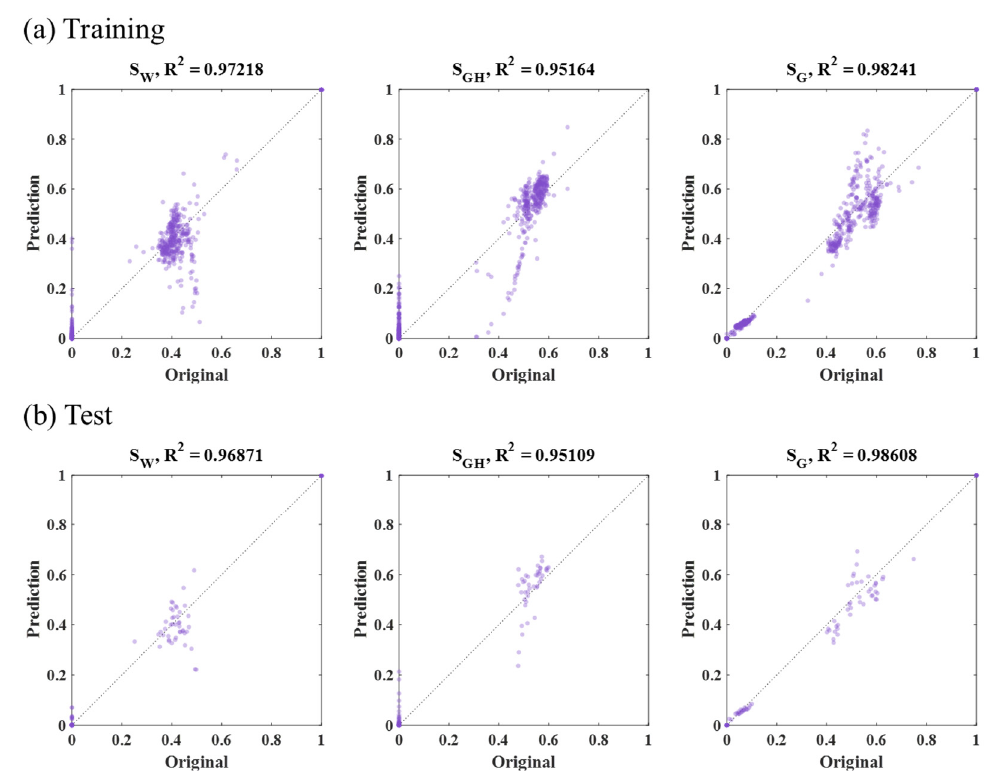
Figure 15. The training ( a ) and test ( b ) results from the CNN with the 1-D vertical input data (Figure